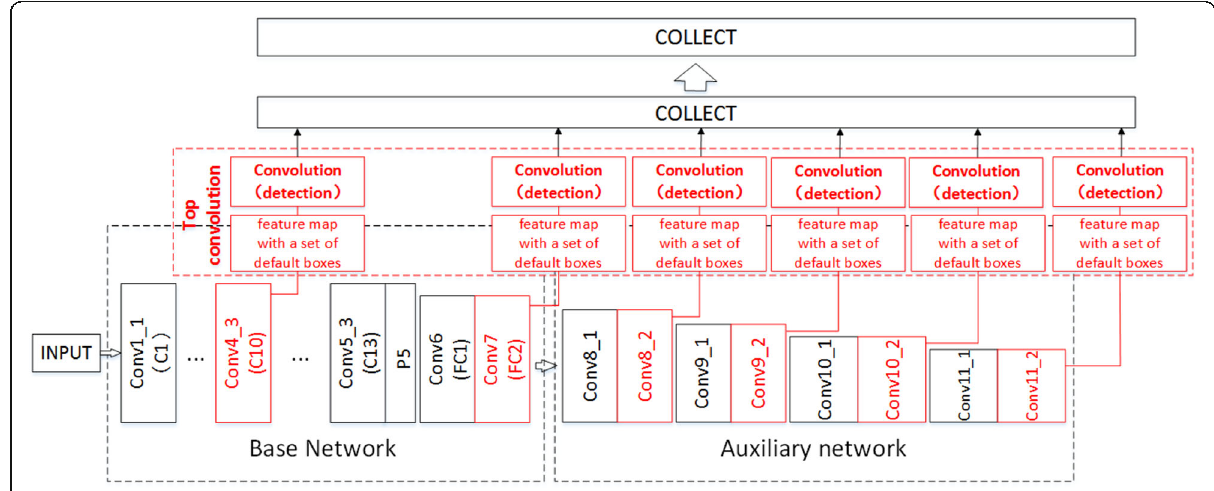
Fig. 2 The network structure of SSD. It adds auxiliary network and top convolution layer to the basic network improved by VGG16 and detects the features of different sizes of feature maps, which improves the accuracy of the